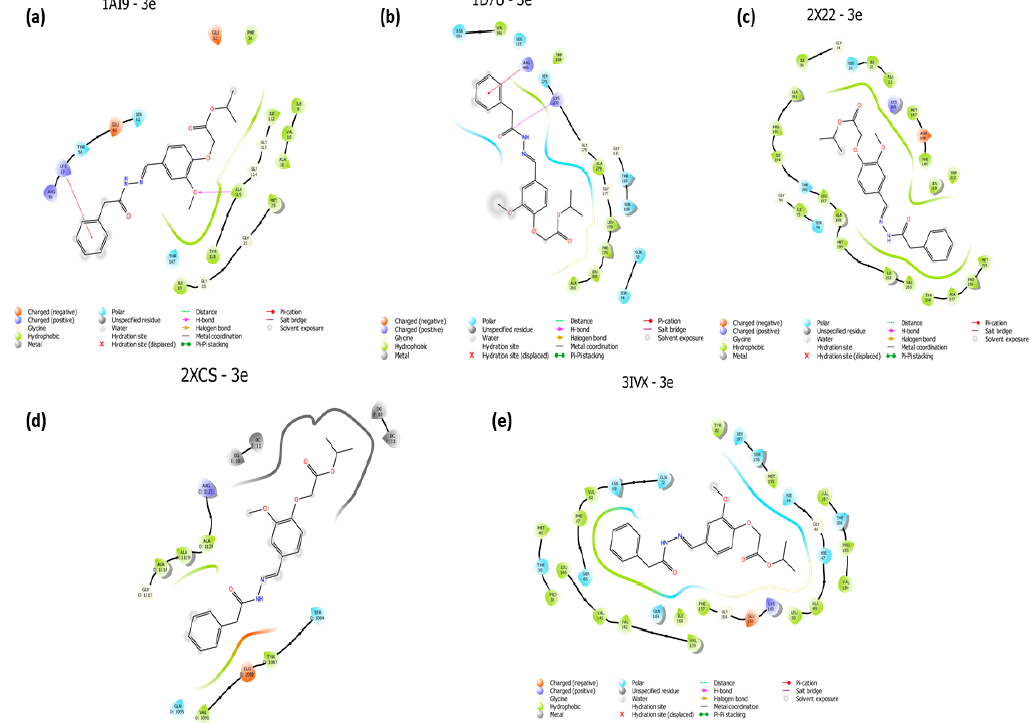
Figure 4. Docking interaction diagrams for best docked, 3e, against various microbial targets, ( a ) 1ai9, ( b ) 1d7u, ( c ) 2x22, ( d ) 2xcs and ( e ) 3ivx.